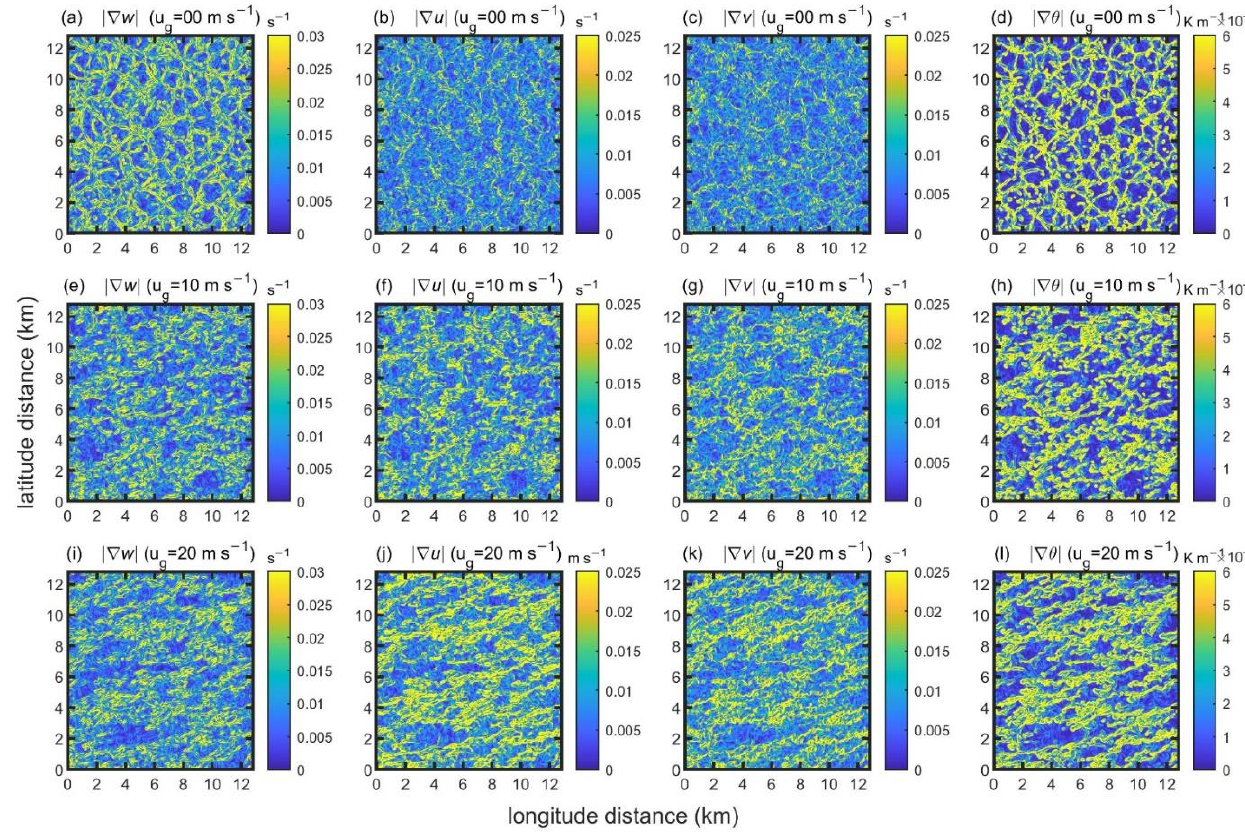
Figure 5. As in Figure 3, but at z / z i = 0.1.